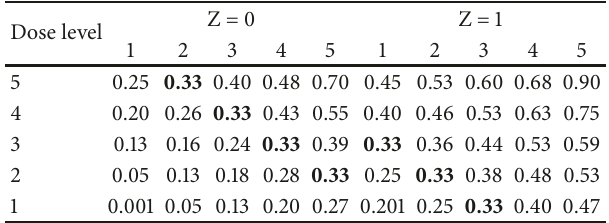
Table 2: A selected dose limiting toxicity scenario with 𝜃 = 0.33 for 𝑍 = 0,1 considering discrete dose combinations. True MTDs are shown in